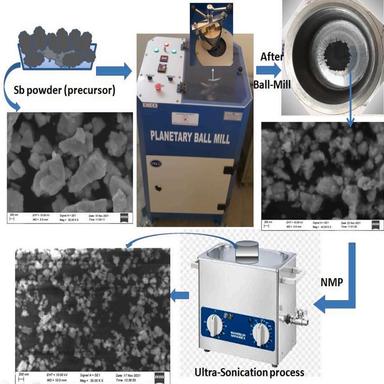
Sb micro-crystalline powders preparation.